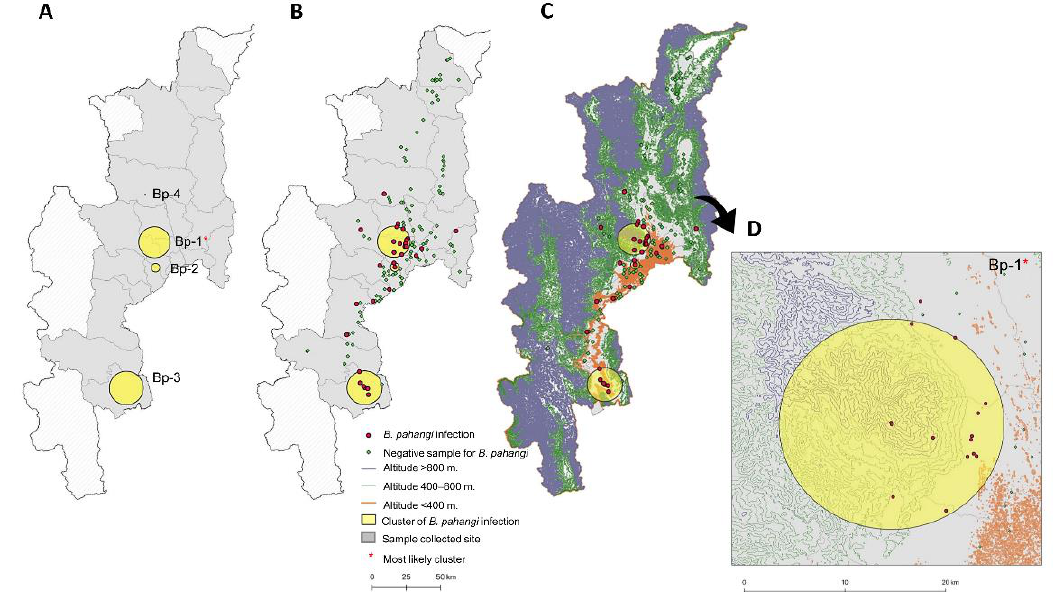
Figure 4. Geographic spatial clusters of B . pahangi infection obtained using the Bernoulli scan statistic model . ( A ) . The distribution of four clusters of B . pahangi infection; ( B ) . the distribution of B . pahangi cases in each cluster; ( C ) . the altitudinal distribution of B . pahangi cases in each cluster; ( D ) . the distribution of B . pahangi cases in the most likely cluster.